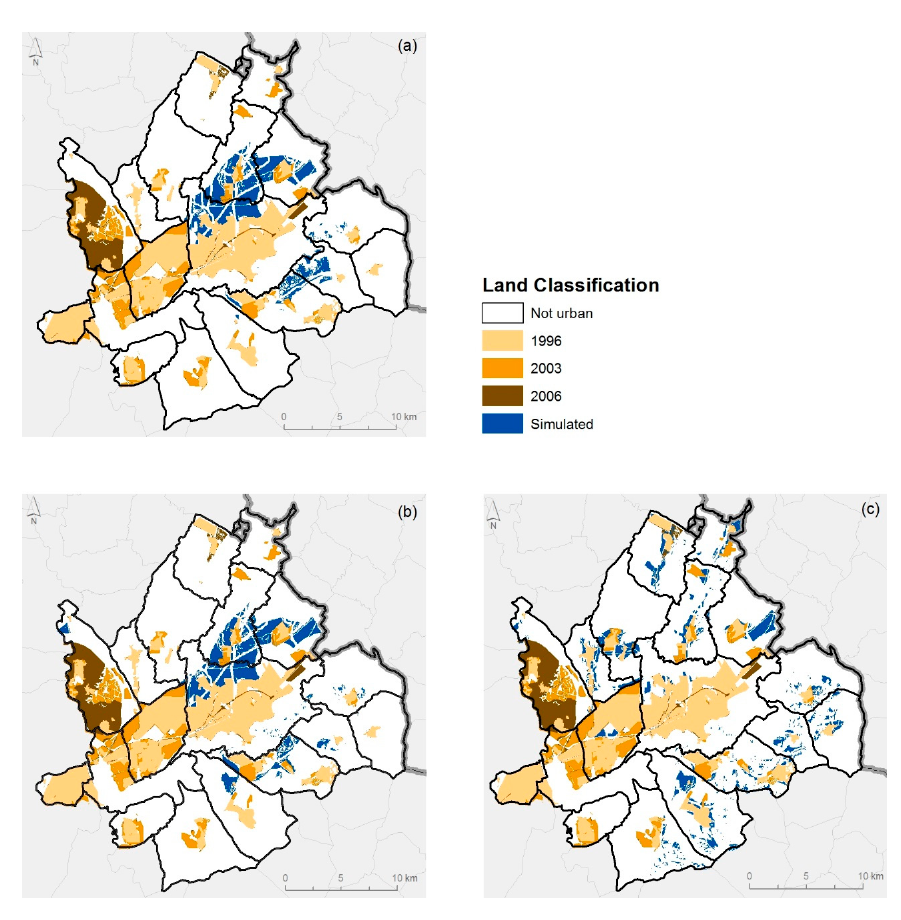
Figure 6. Comparison of simulation results (five years) and real data on past urban plans for the three planner profiles: ( a ) sustainable, ( b ) conservative, ( c ) speculative.